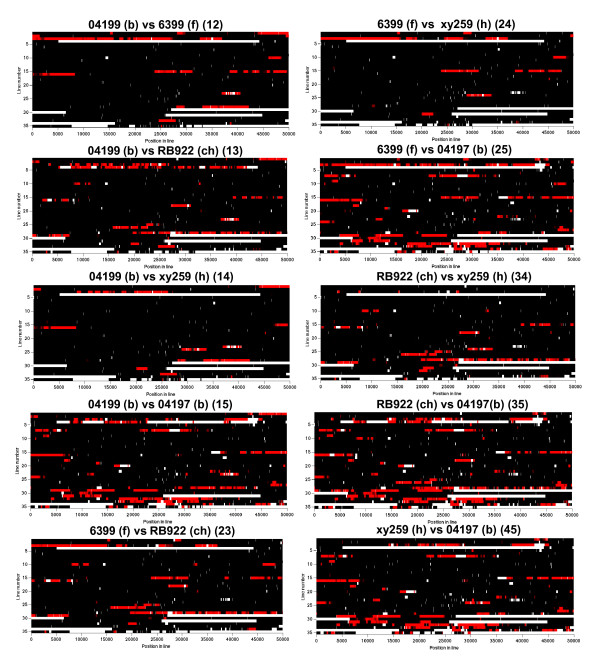
Pairwise nucleotide comparisons of five complete ST-21 C. jejuni genome sequences. The comparisons were performed using a Bayesian statistics model [25], with black representing identical sequence stretches, white representing non-aligned (unrelated or missing) sequences, and red areas indicating imported/recombined stretches of sequence (h = human; ch = chicken; f = food; b = bovine). The two-digit number behind each header indicates the strain comparison (each digit corresponds to one strain), equivalent to Additional File 3: Table S10. The intensity of each color represents statistical uncertainty. One horizontal line (line number of y-axes) is equivalent to 50,000 kilobases (position in line of the x-axes corresponds to the basepair count). For all alignments, strain 04199 (largest genome, strain number 1 in genome alignments) was used as a reference genome.